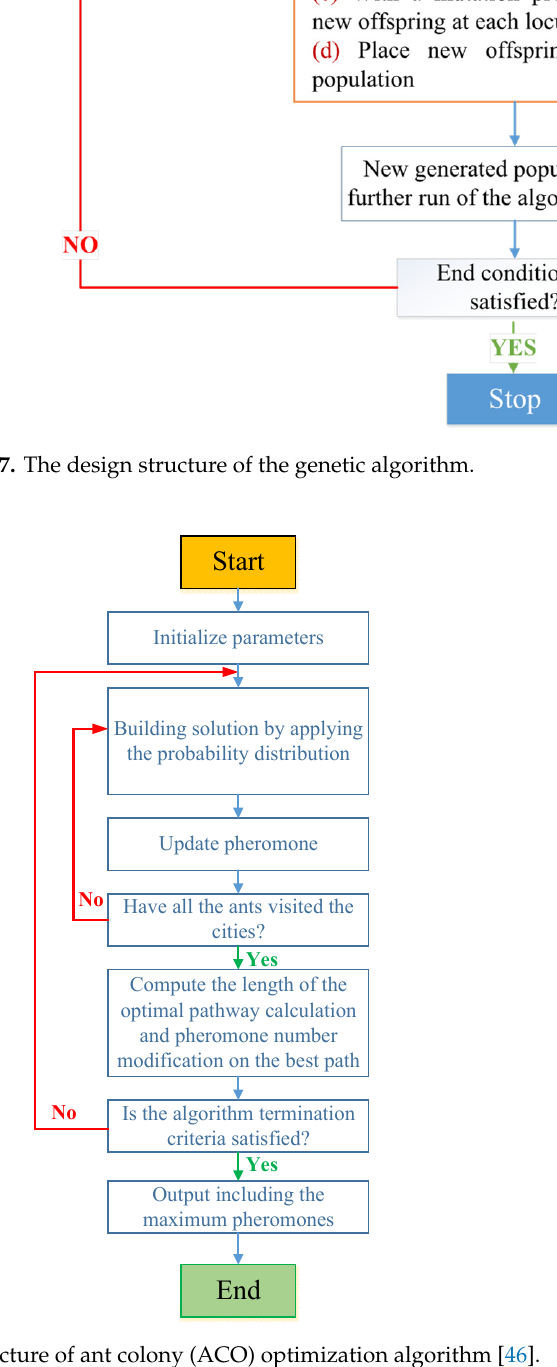
Figure 7. The design structure of the genetic algorithm.